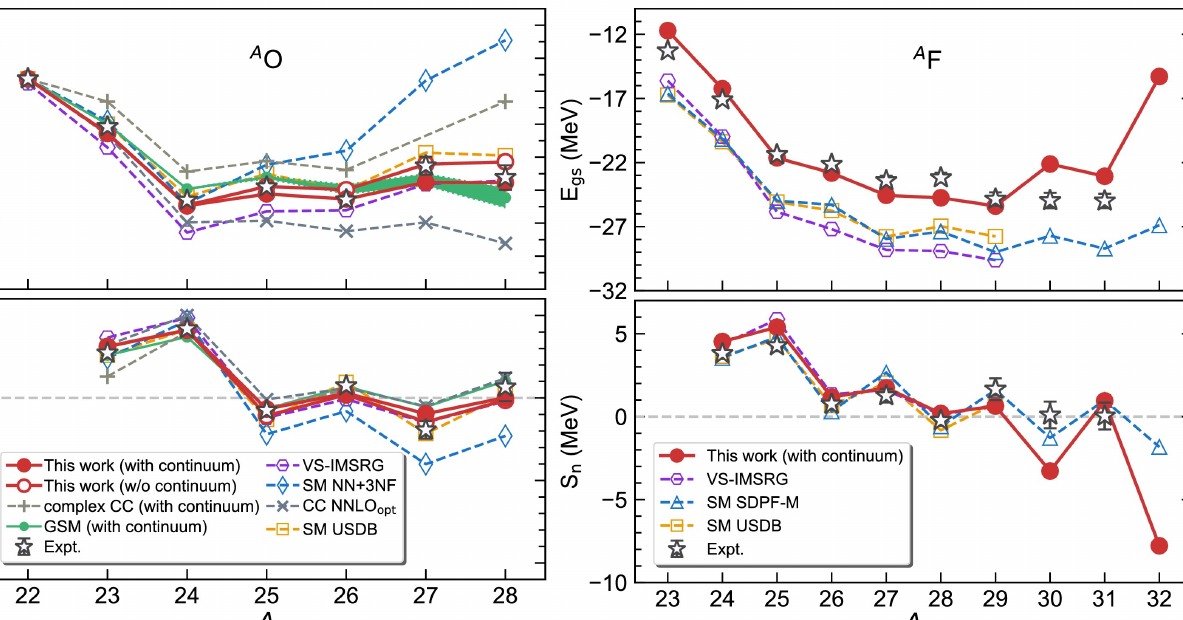
Figure 4. Calculated ground-state energies ( upper panel ) with respect to the 22 O core and associated neutron separation en- ergies S n ( lower panel ) for oxygen and fluorine isotopes, compared with experimental data [78] (the AME2016 extrapolated values are taken for 27,28 O and 30,31 F) and theoretical calculations from other groups: complex coupled-cluster (CC) with next-to-next-to-next-to-leading-order nucleon-nucleon CC with NNLO opt interaction [79], GSM [80], –space in-medium similarity renormalization group (VS-IMSRG) [81], SM with NN+3NF [82], SM with USDB [68], and SM with SDPF-M [83] (with permissions from Ref.